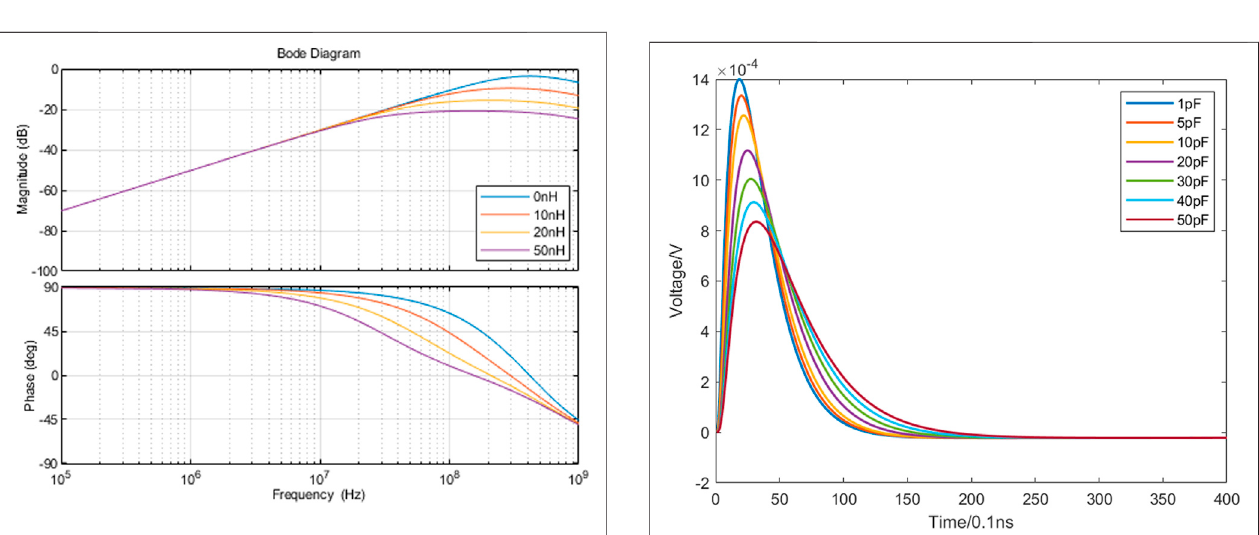
FIGURE 13 | Effect of C 1 on sensor detection performance.